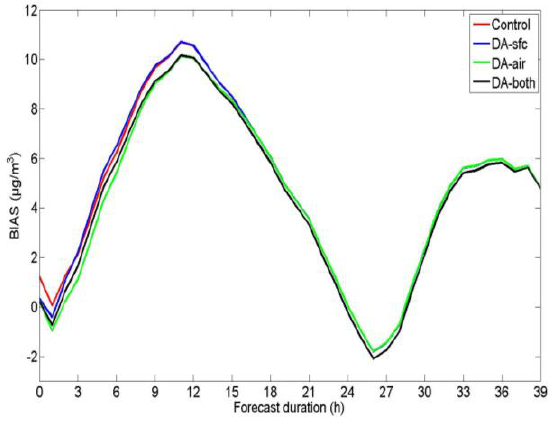
Fig 4 Correlations (a), root-mean-square errors (RMSE) (b) and BIAS (c) of the total PM 2.5 concentration forecasts against observations as a function of forecast